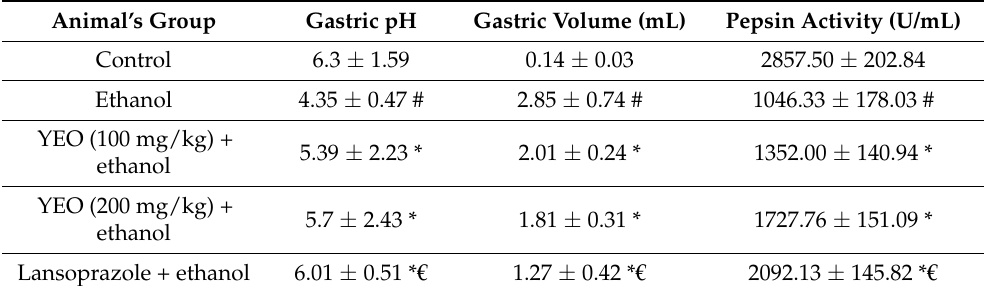
Table 2. Effect of yarrow oil on gastric pH and volume and pepsin activity of gastric juice in various experimental